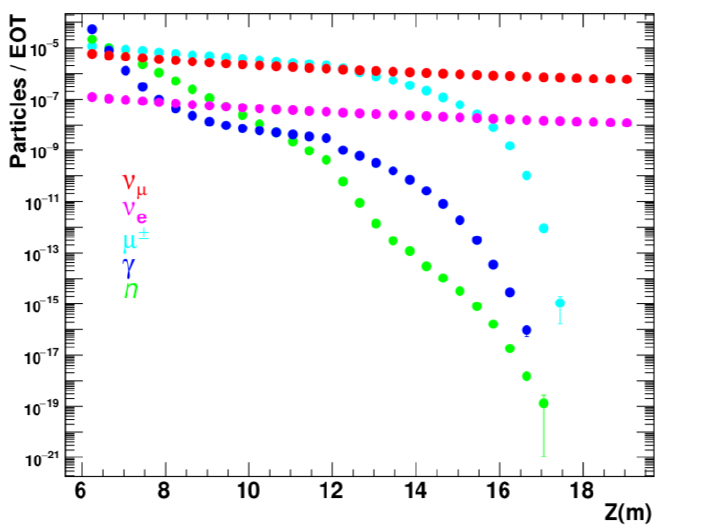
Figure 4. Particle rates per EOT at different depths in the shielding. Particle transport threshold was fixed to 100 MeV (10 MeV for